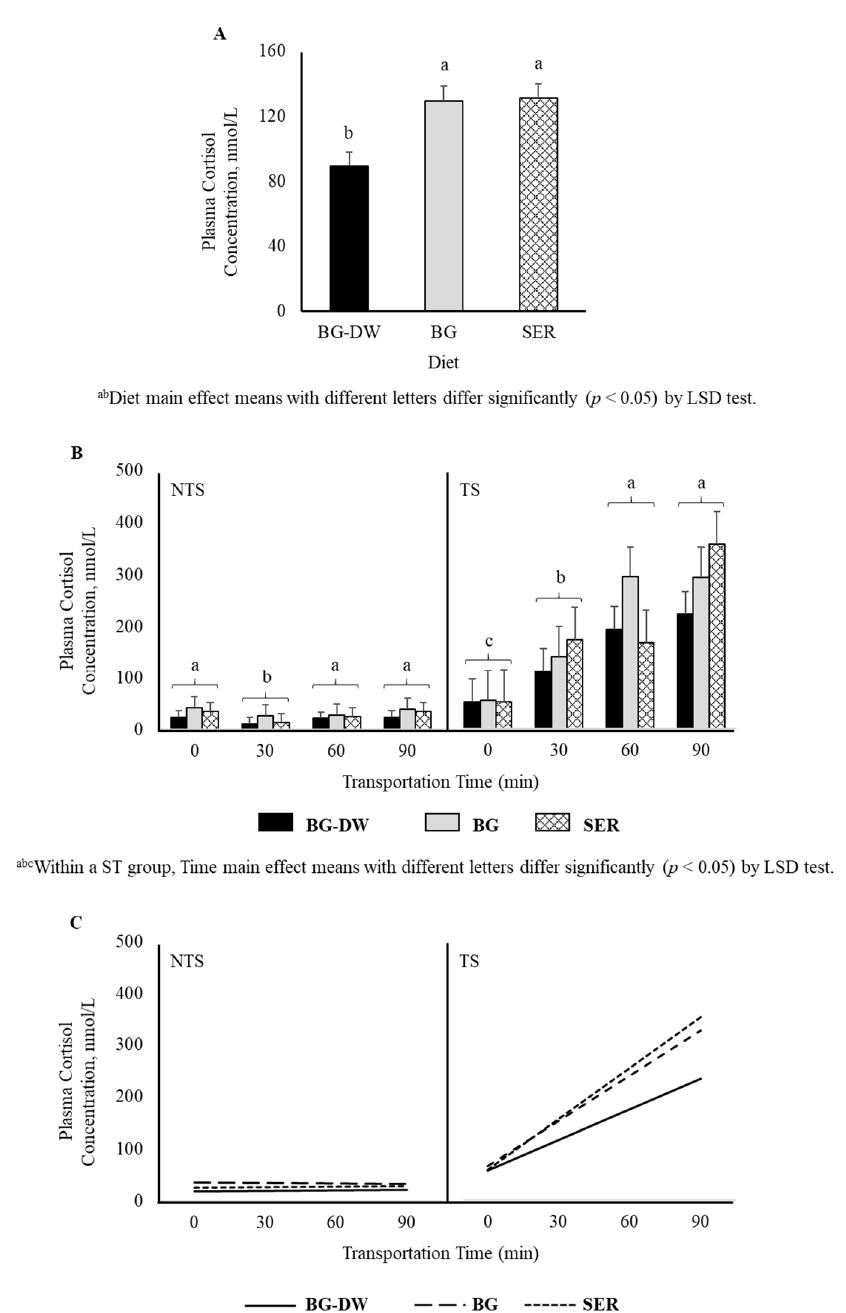
Figure 1. ( A ) Effects of Diet (BG-DW: bermudagrass hay—dewormed; BG: bermudagrass hay; SER: sericea hay; p < 0.05) and ( B ) Stress Treatment (ST; NTS: non-transported; TS: transported; p < 0.01) and Time ( p < 0.01; ST × Time, p < 0.01) on plasma cortisol concentrations in goats. Bars represent means with SEM. ( C ) Polynomial contrasts showing a significant linear trend ( p < 0.01) over